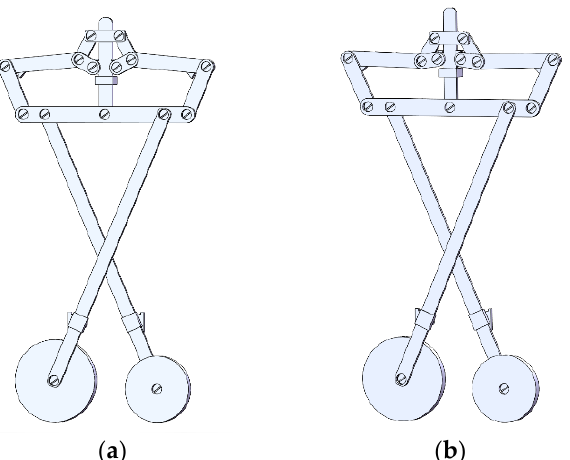
Figure 8. Prototype of the planar underactuated compaction mechanism with ( a ) the compliant state and ( b ) the stiff state.